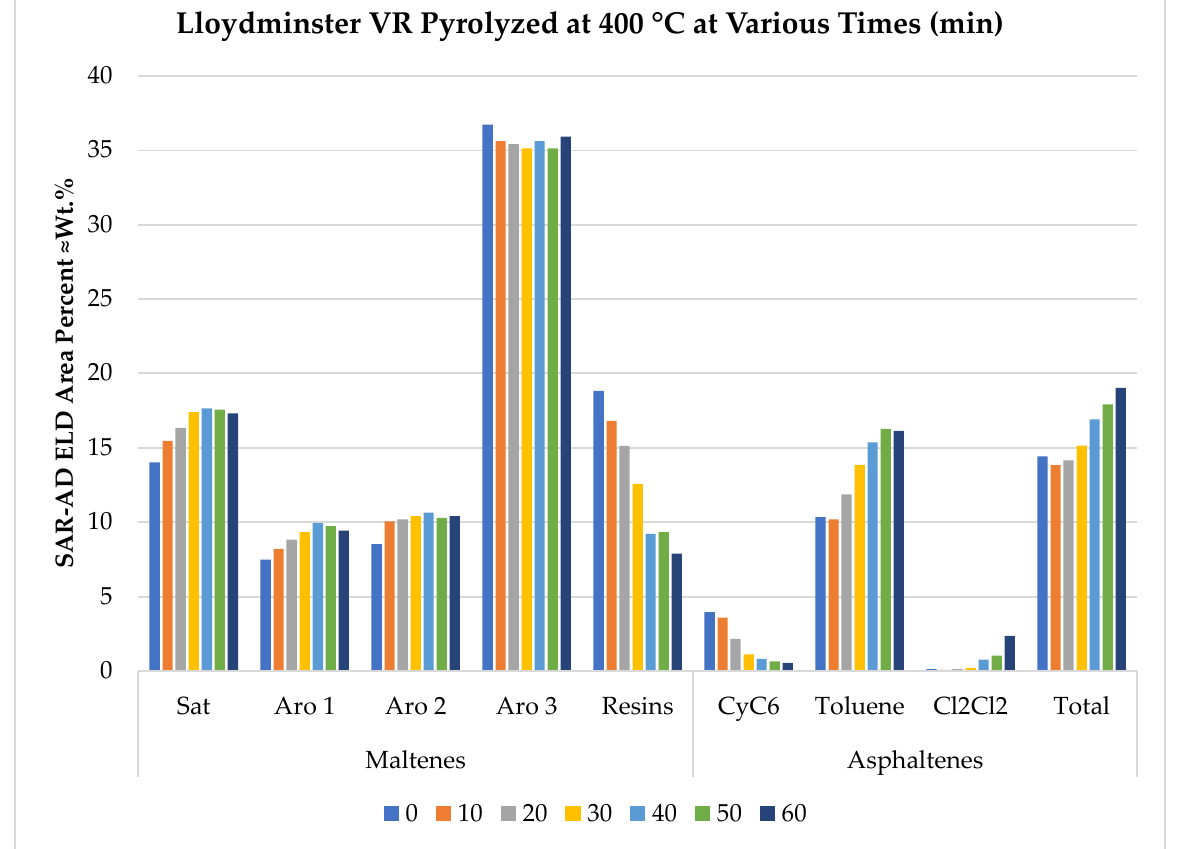
Table 7. SAR-AD data for liquids produced from Lloydminster asphaltenes after heating to 500 °C. Sample ID